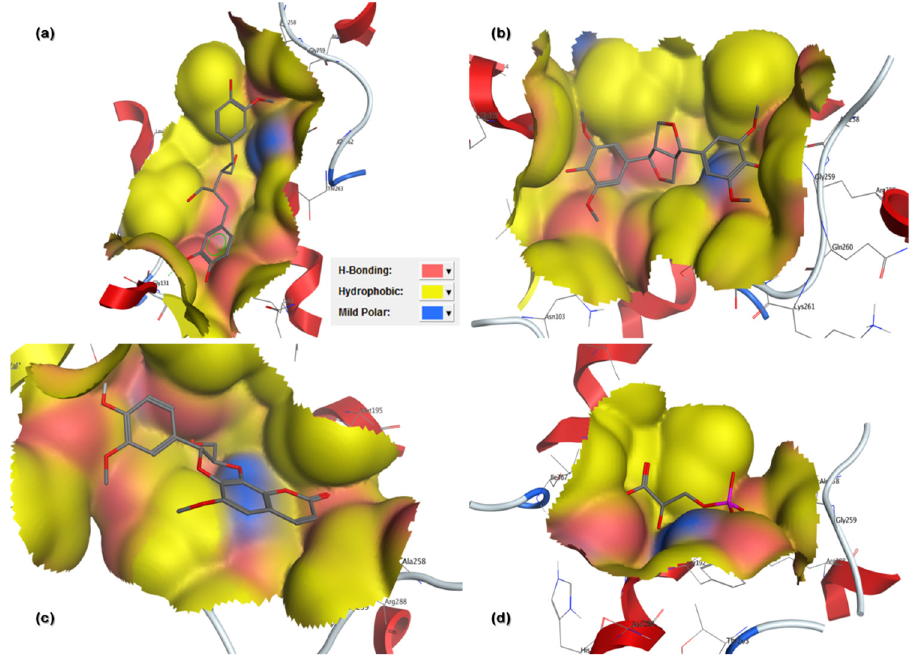
Figure 3. Three-dimensional (3D) binding pattern maps of hits in 6-PGD binding site representing H-bond (pink), hydrophobic interaction (yellow) and mild polarity (blue): ( a ) secoisolariciresinol and 6-PGD forming arene-cation and side-chain hydrogen bonds; ( b ) syringaresinol forming side-chain hydrogen bond acceptor and donor; ( c ) cleomiscosin A forming side-chain hydrogen bond acceptor and donor; ( d ) 3-PG forming side-chain hydrogen bond acceptor and donor. Table 1. Potential hits summary: their binding score, RMSDs, residual interaction and H-bonds.